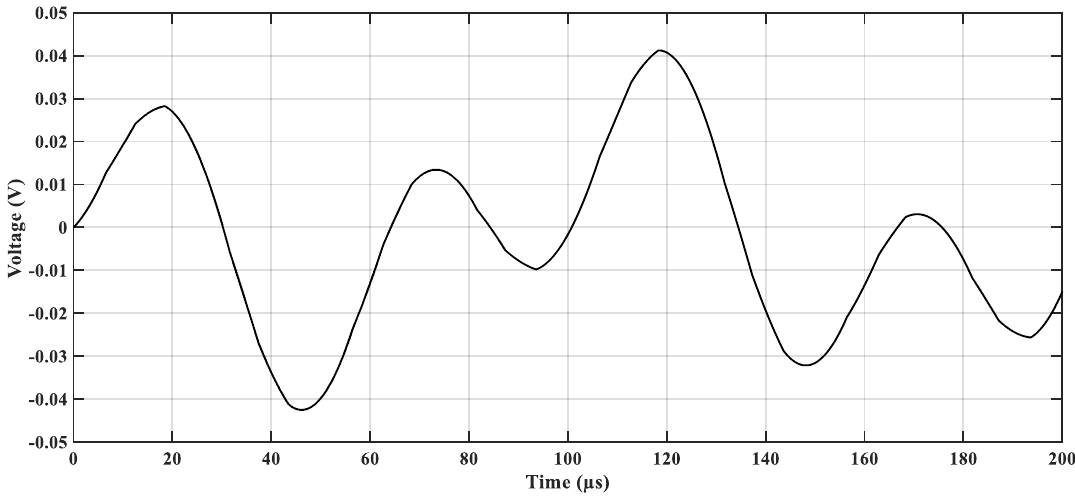
Figure 8. Common-mode voltage with the ACMVC.